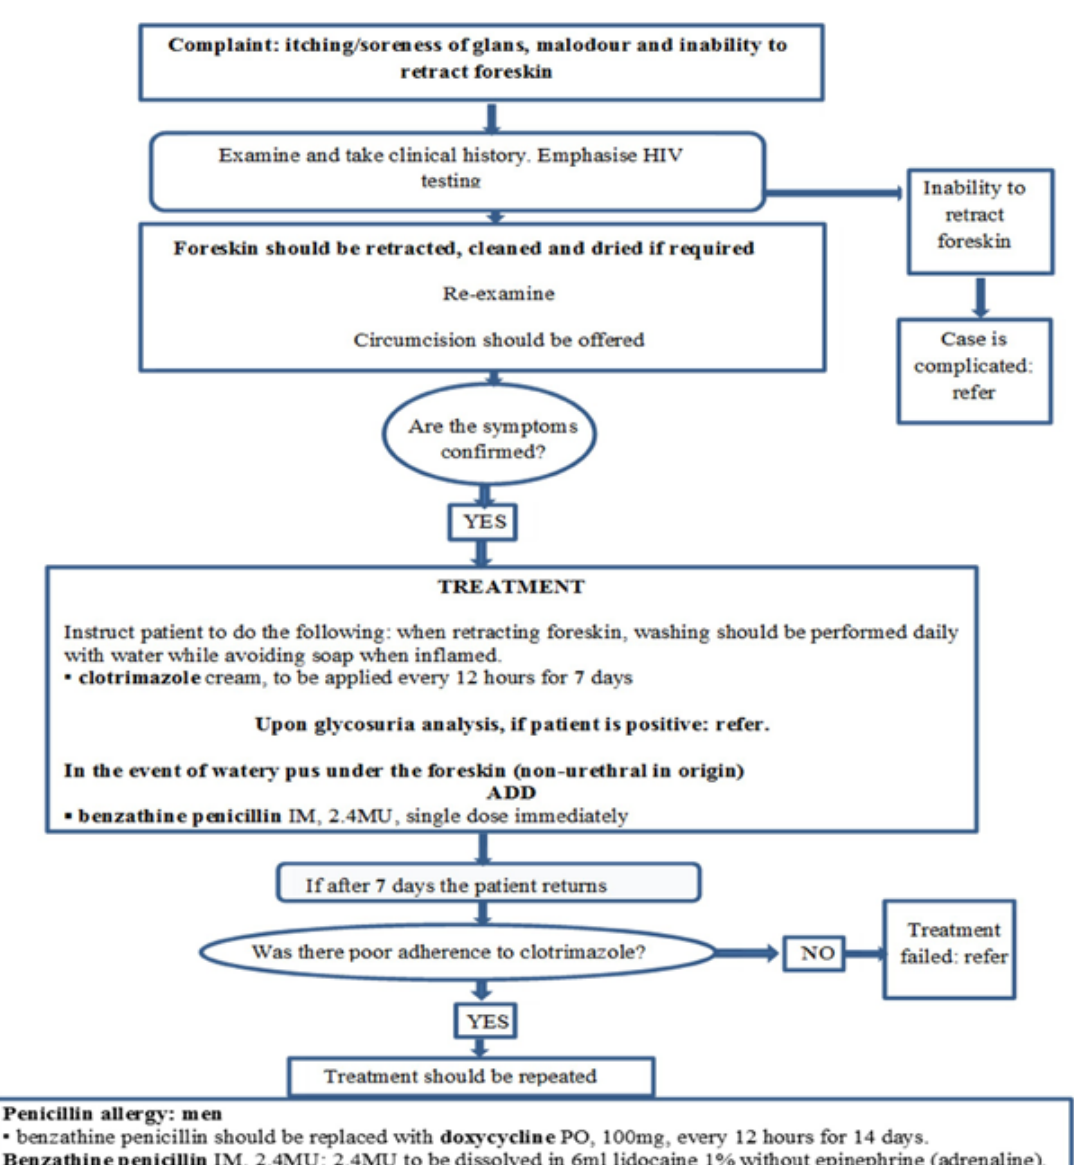
Figure 7: Flowchart of syndromic treatment of balanitis/balanoposthitis. (adapted from the revised balanitis/balanoposthitis flowchart of the Primary Health Care Standard Treatment Guidelines and Essential Drugs List, 2015)